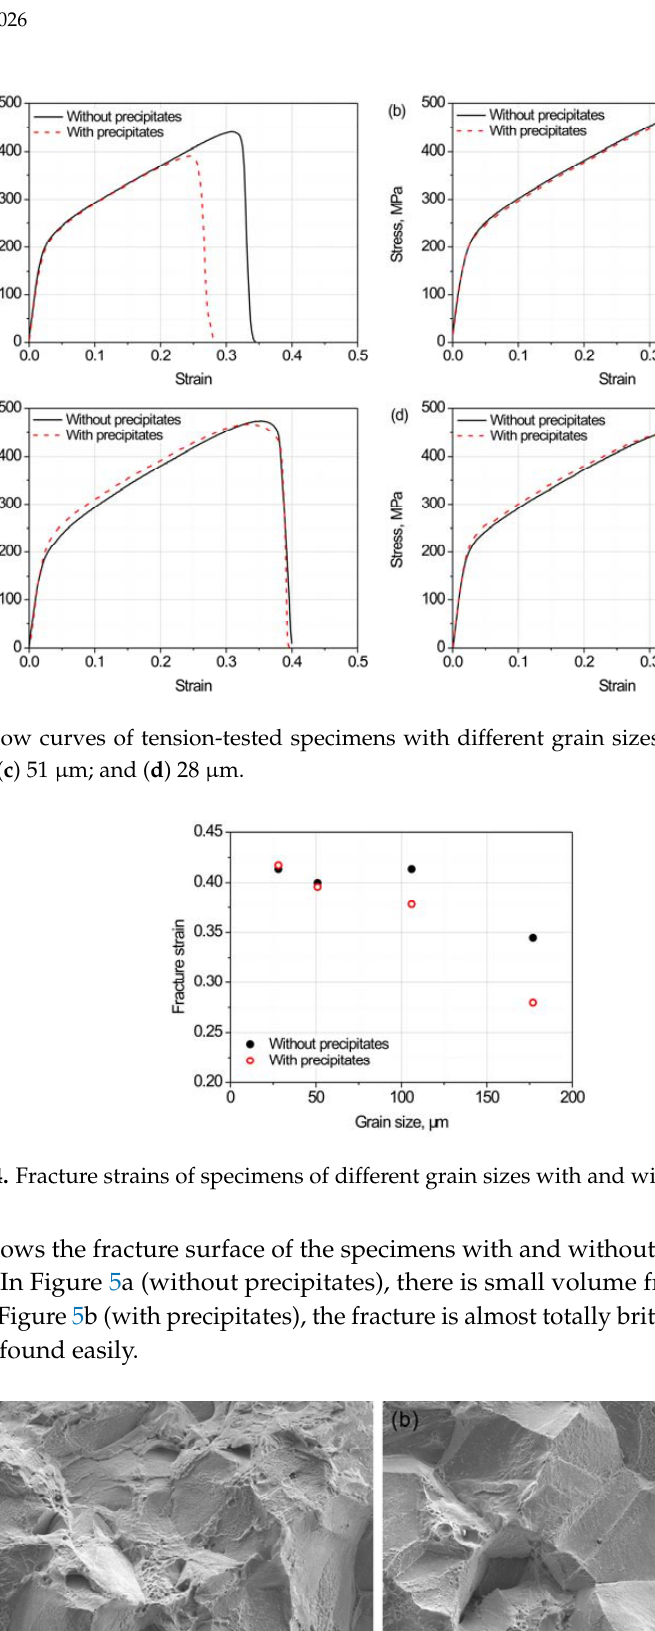
Figure 5. Fracture surface of specimens with a grain size of 177 μ m: ( a ) without precipitates ( b ) with precipitates.